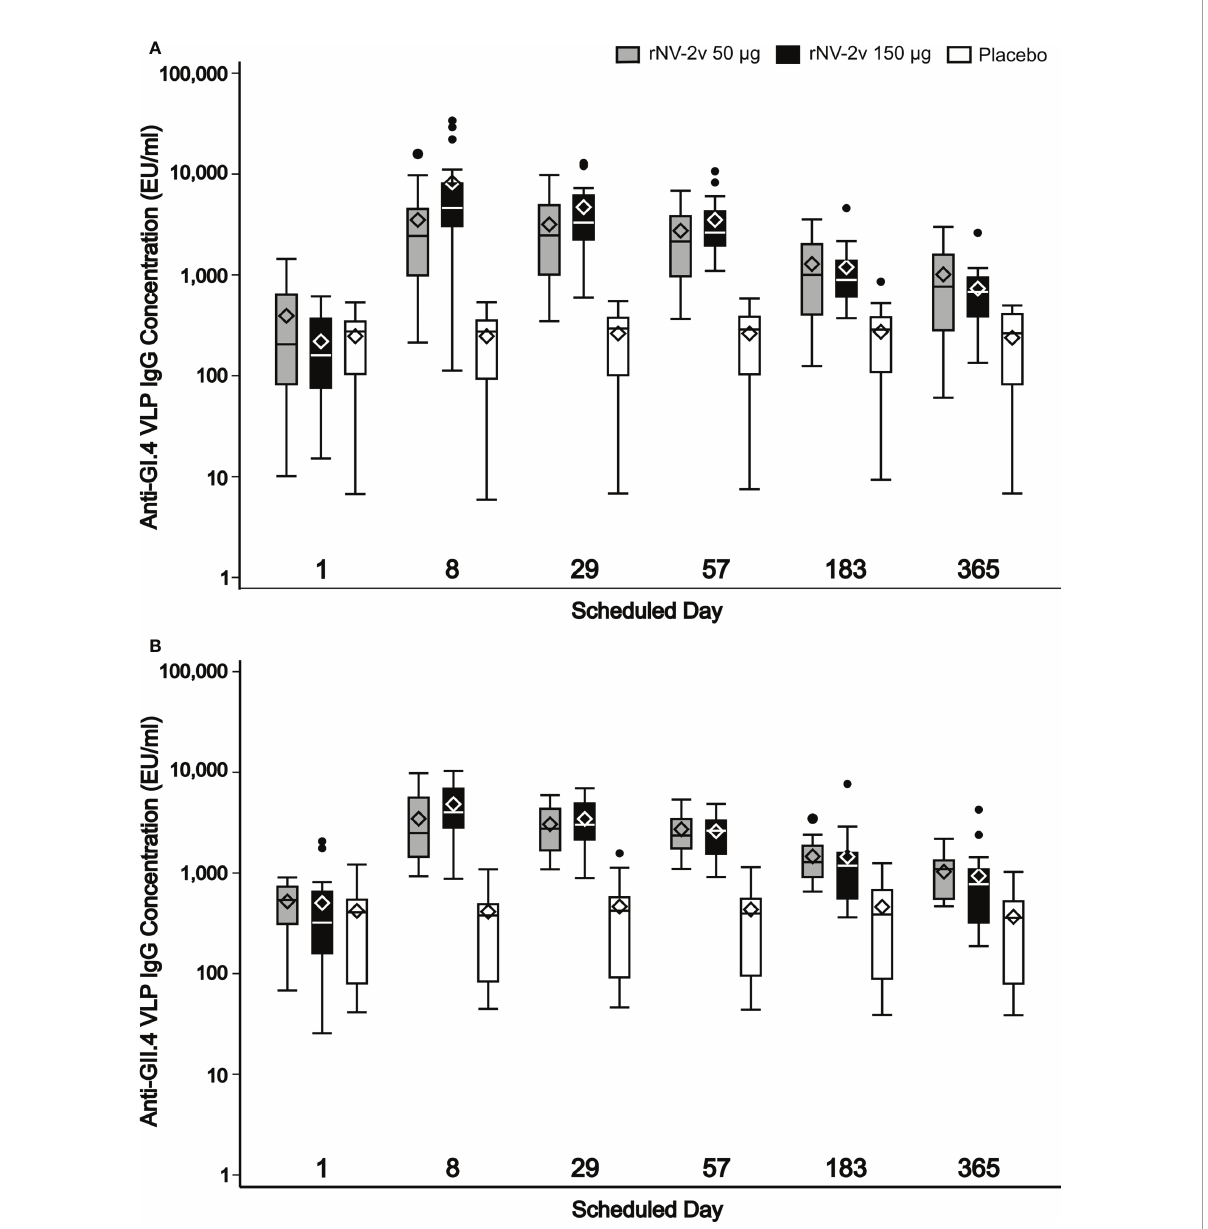
FIGURE 4 Humoral anti-GI.4 and anti-GII.4 VLP IgG responses. Humoral anti-GI.4 and anti-GII.4 VLP IgG responses by scheduled time for each treatment. OD values were processed using a 4-parameter logistic fi tting algorithm to the standard curve, allowing the determination of antibody concentration in the samples, expressed as EU/mL. Anti-GI.4 (A) and anti-GII.4 (B) . VLP IgG responses for rNV-2v 50 µg (grey), 150 µg (black) and placebo (white) are shown as boxplots. The horizontal line represents the median, the bottom and top of the box represent 25 th and 75 th percentiles of the values, respectively, and the upper and lower error bar represent 5 th and 95 th percentile of the values, respectively. Diamond indicates mean value. Dots represent outliers. IgG, immunoglobulin G, VLP, virus-like